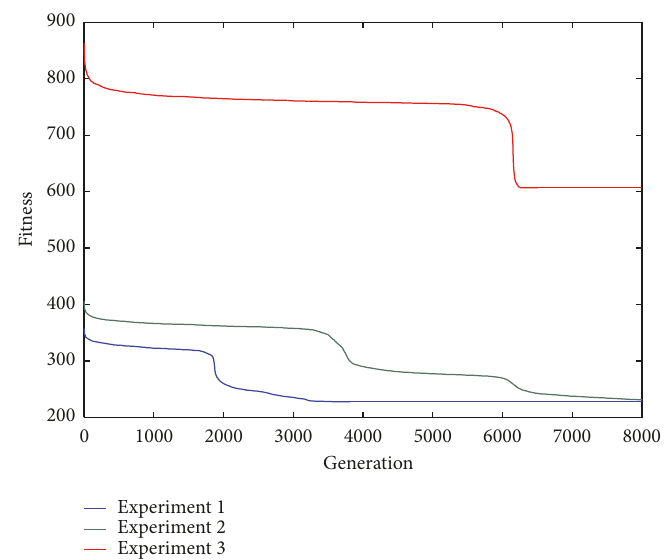
Figure 5: The evolution process of road network in Experiment 1, Experiment 2, and Experiment